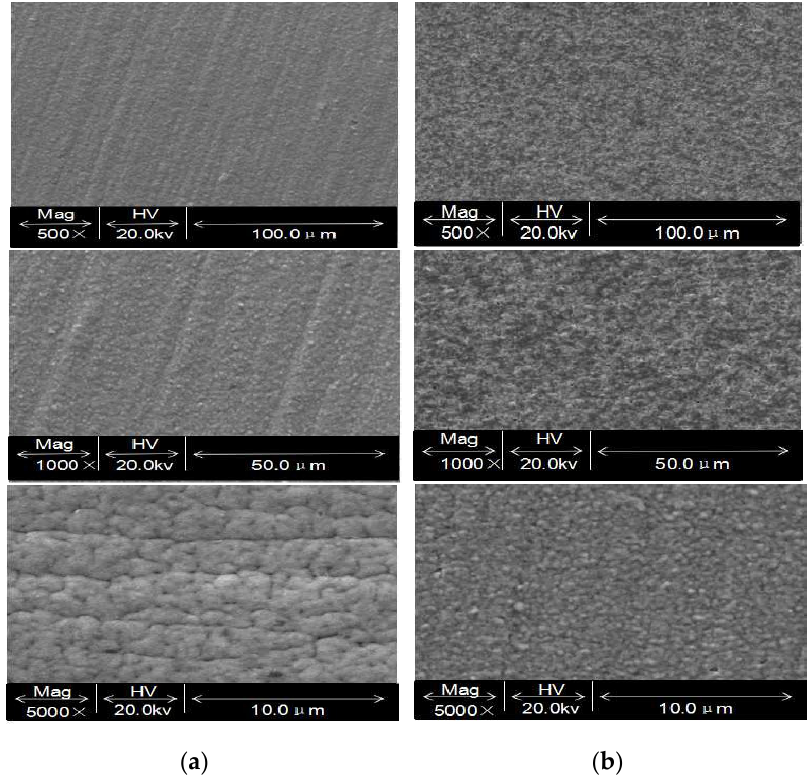
Figure 6. SEM image of pure nickel coating and Ni/ZrO 2 gradient coating under different magnification: ( a ) Ni coating, ( b ) Ni/ZrO 2 gradient coating.